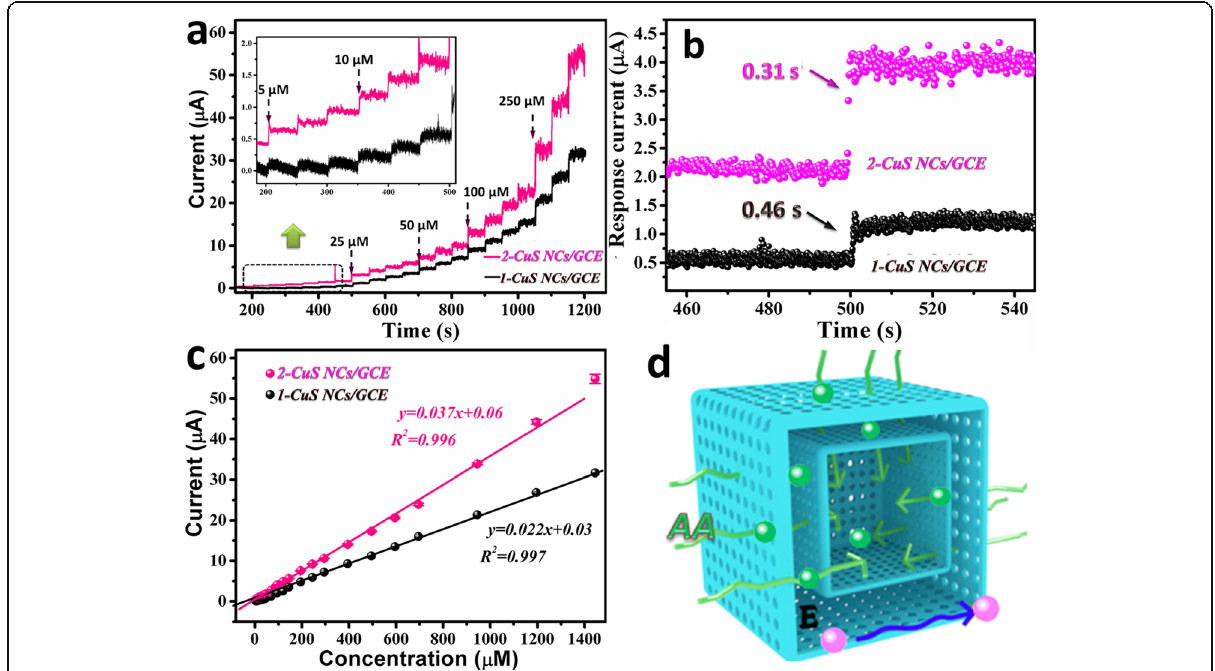
Fig. 5 a i - t response at different working potentials. b i - t response of 2-CuS NCs/GCE and 1-CuS NCs/GCE at 0.25 V. c The corresponding calibration plot of b . d The illustration of dynamic advantages for 2-CuS